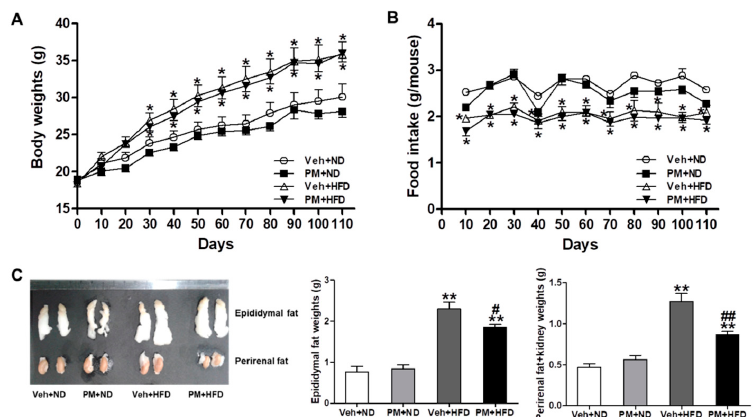
Figure 4. The effect of PM extract on body weight, food intake, and weight of adipose tissues in normal diet (ND)- or high-fat diet (HFD)-fed mice. The mice were administered PM extract or vehicle orally for 16 weeks, and the adipose tissues were collected. Body weight ( A ) and food intake ( B ) were measured every 10 days for 16 weeks. At sacrifice, representative images of epididymal and perirenal fats were taken, and the weight of these fats were measured. Data are the mean ± SEM. * p < 0.05 and ** p < 0.01 vs. Veh + ND group; # p < 0.05 and ## p < 0.01 vs. Veh + HFD